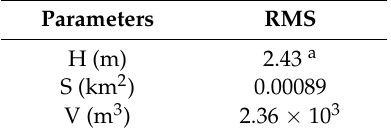
Table 7. Accuracy (root mean square (RMS) errors) for the parameters used in the extracted deformation.